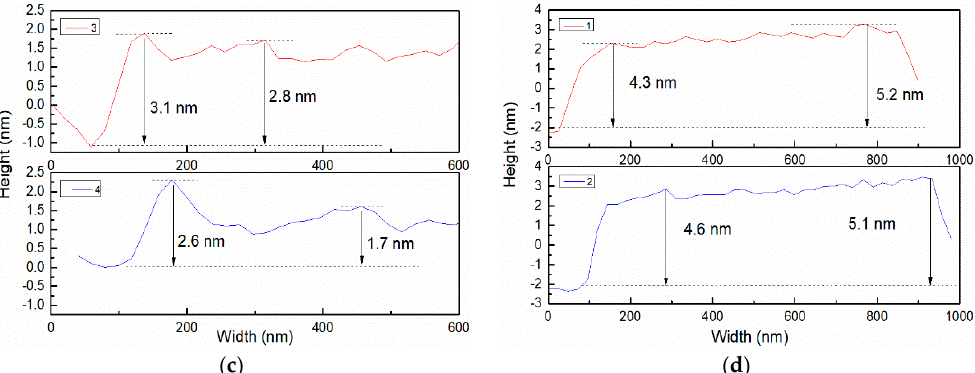
Figure 5. Tapping-mode atomic force microscope (AFM) images: ( a ) graphene, ( b ) nanocomposite TPG and corresponding height profiles of ( c ) GE and ( d ) TPG.